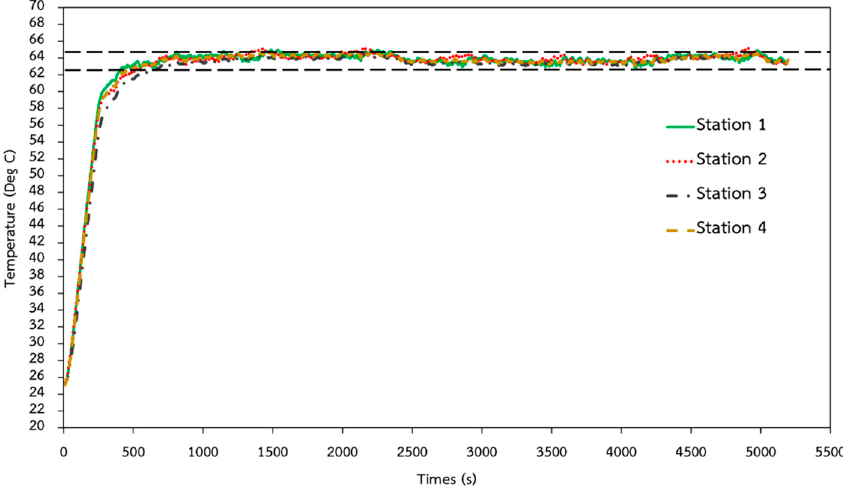
Figure 12. Temperature validation of sample droplets at four testing stations.